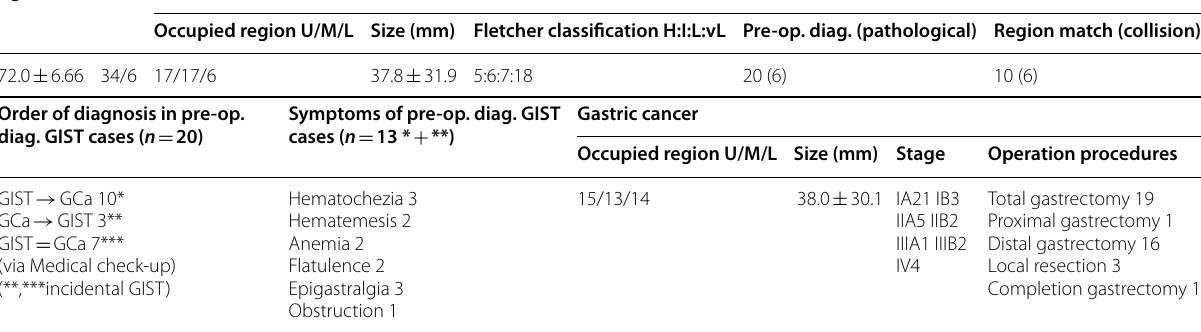
Table 1 Summary of synchronous gastric cancer and GISTs of the stomach in Japanese literature ( n Age